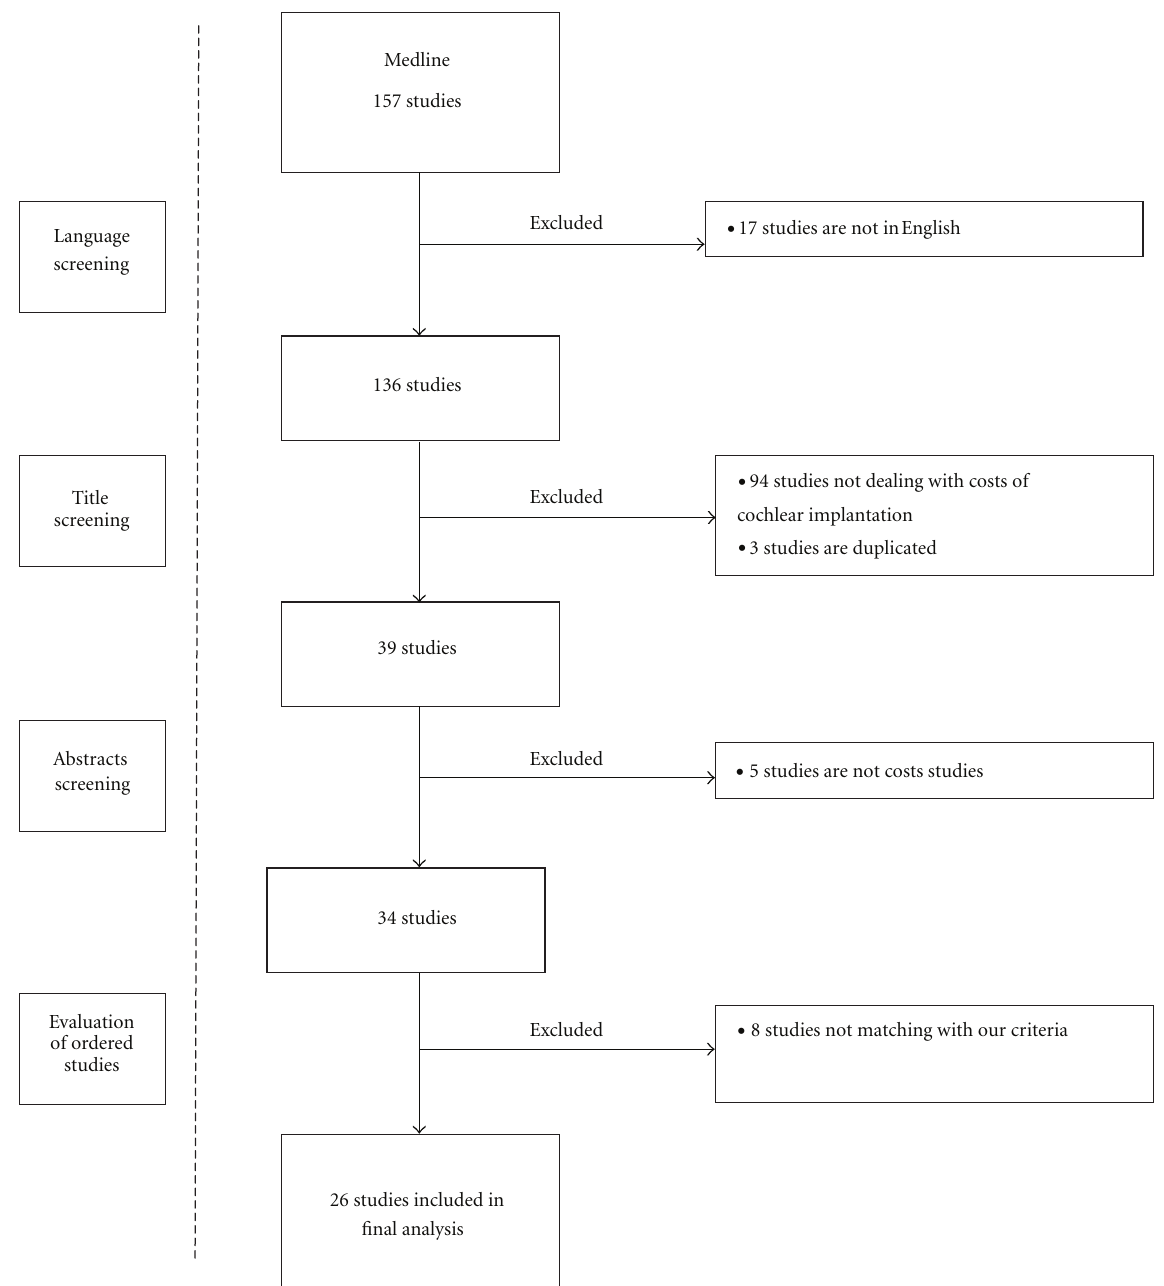
Figure 1: Literature search and selection